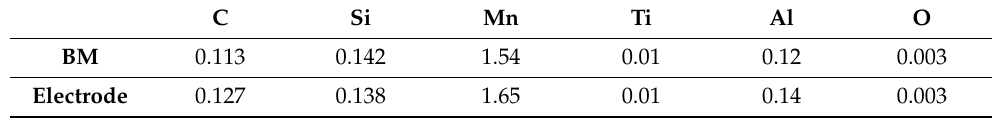
Table 2. Measured chemical compositions of the BM and electrode (wt pct)